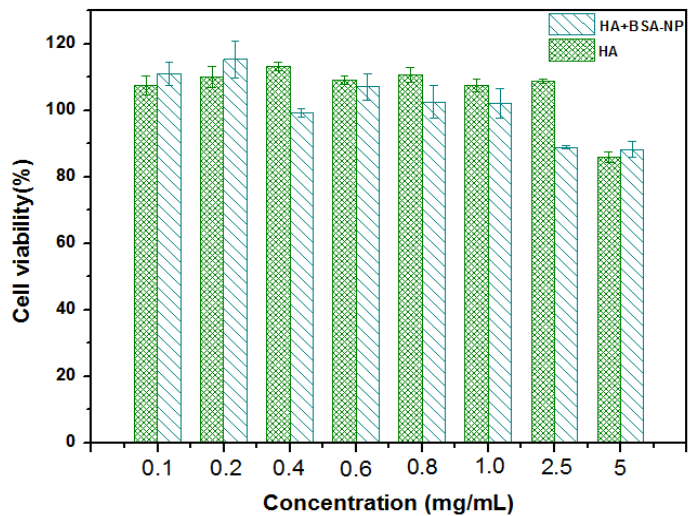
Figure 8. Cell viability of Ana-1 cells exposed to HA and HA + BSA-NPs.